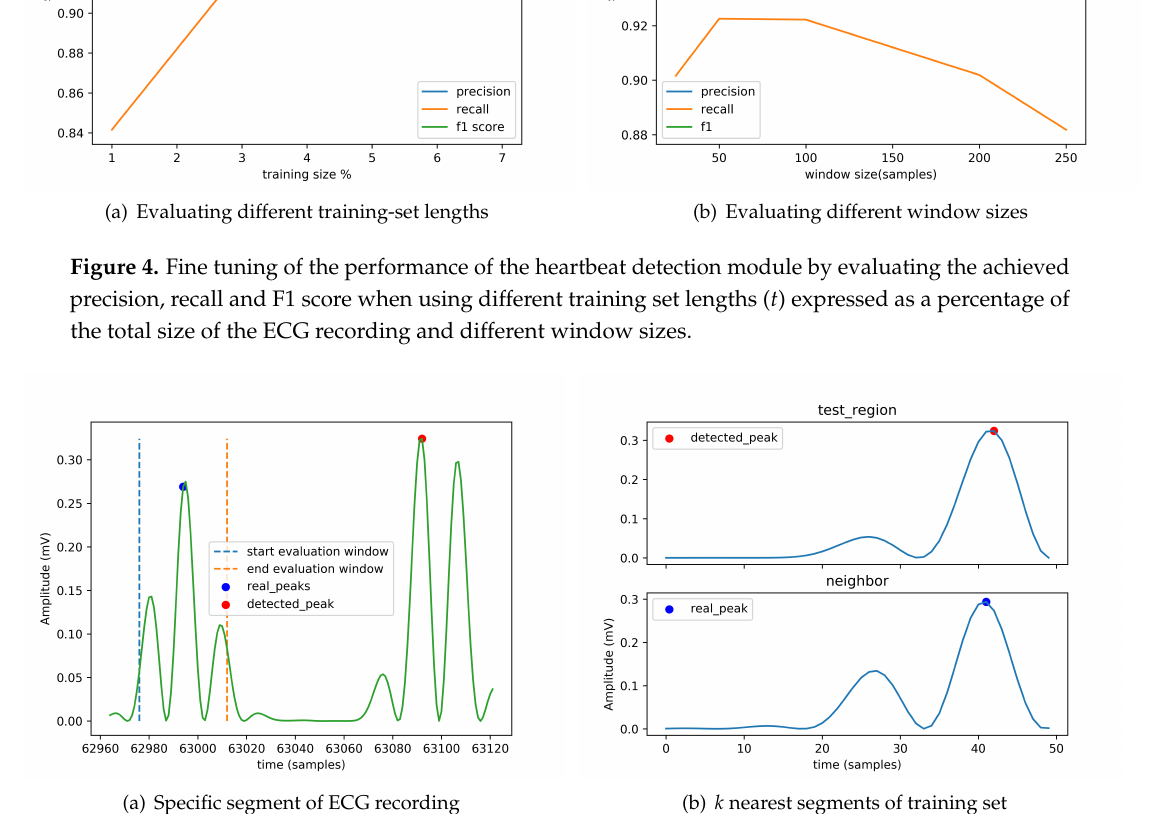
Figure 5. Erroneous detection of an R peak on a specific segment of ECG recording labeled “101” of the dataset when k = 1 and using simple majority voting. The signal plotted is the result of the filtering and the squaring